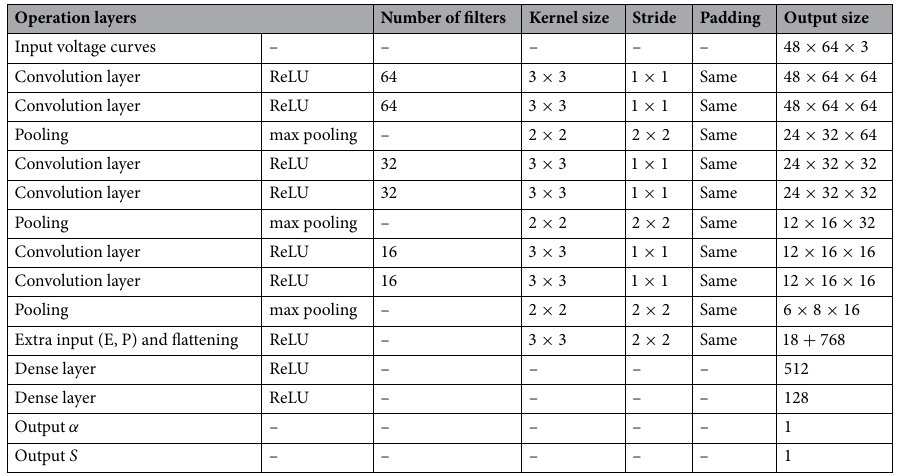
Table 1. Network architecture